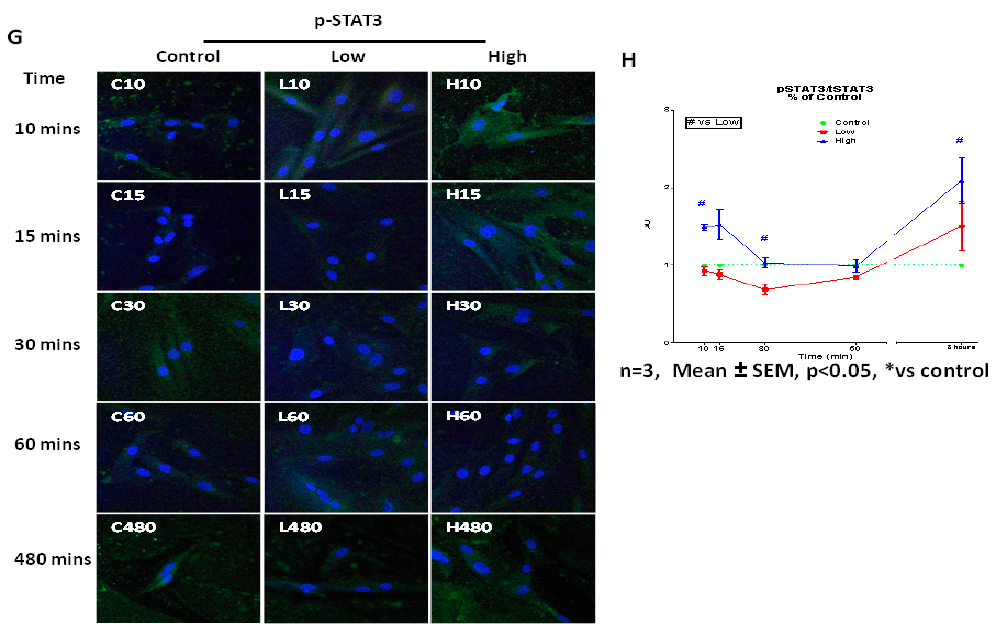
Figure 9. E ff ect of low and high IL-6 concentrations on JAK1 and JAK2 phosphorylation in PHMs. ( A ) E ff ect of low and high IL-6 concentration on JAK1 phosphorylation over 8 h. ( B ) E ff ect of low and high IL-6 concentration on JAK2 phosphorylation over 8 h. ( C ) Quantification of p-JAK1 as shown in ( A ). ( D ) Quantification of p-JAK2 as shown in ( B ). ( E ) Immunofluorescence staining for p-JAK1 after treatment of PHMs with low and high IL-6 concentration over 8 h. ( F ) Immunofluorescence staining for p-JAK2 after treatment of PHMs with low and high IL-6 concentration over 8 h. ( G ) Immunofluorescence staining for p-STAT3 after treatment of PHMs with low and high IL-6 concentration over 8 h ( H ) Quantification of p-STAT3 levels as shown in ( G ). The experiment was repeated three times. All immunofluorescence images were taken at 100 × magnification. Results are presented as mean ± standard error of the mean (S.E.M). Statistical analysis: ANOVA and Bonferroni post hoc test. * p < 0.05; ** p < 0.01; *** p <